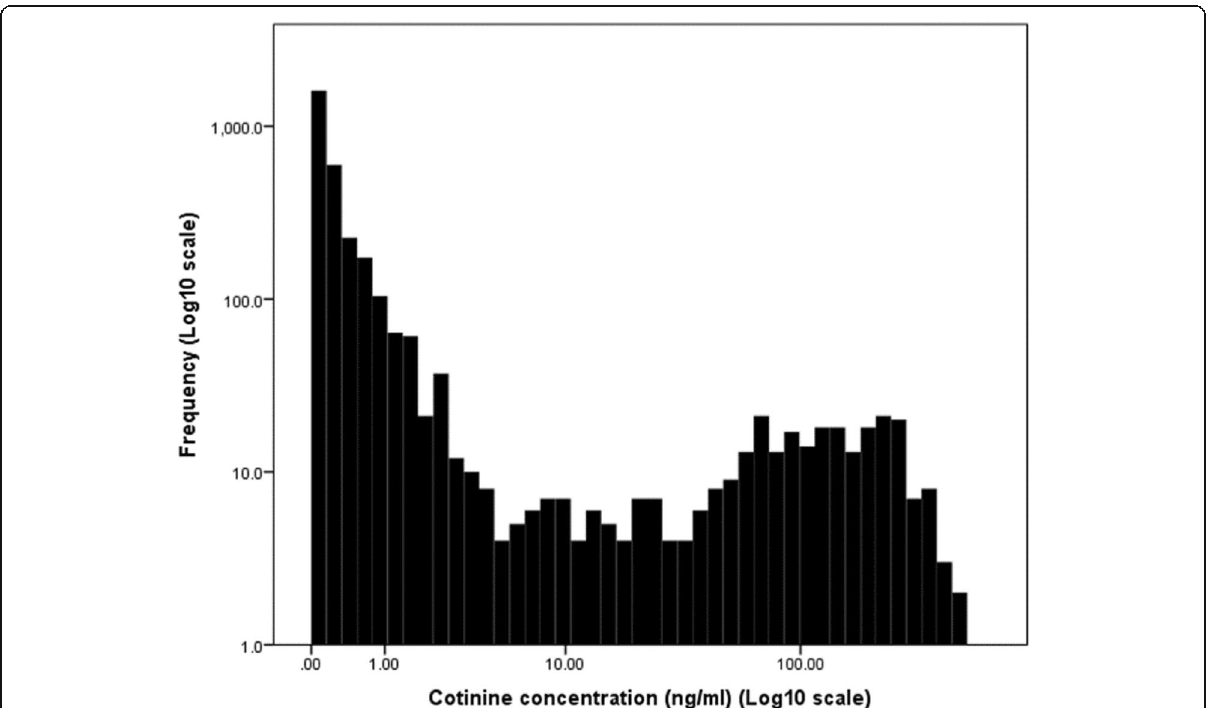
Fig. 2 Frequency distribution of maternal cotinine levels in the third trimester. The distribution of log 10 transformed maternal cotinine levels at the third trimester was described